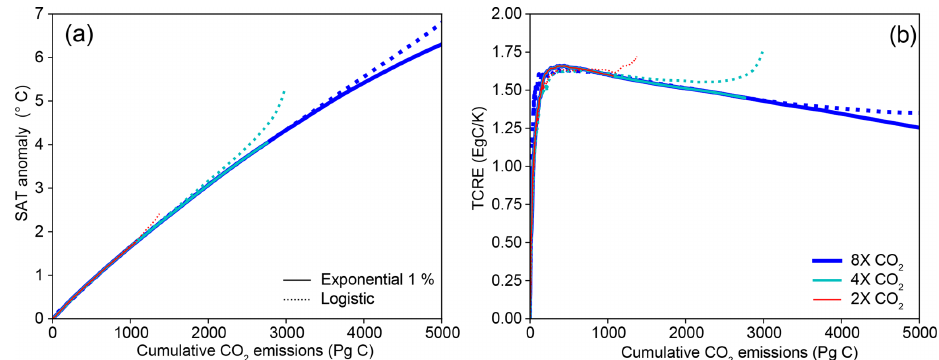
Figure 9. (a) Temperature change versus cumulative emissions curve and (b) TCRE values for all logistic and 1% experiments. Logistic experiments are shown with dotted lines; 1% experiments are shown with solid lines. TCRE exhibits strong path independence except near the end of the logistic experiments when the implied rate of emissions slows.